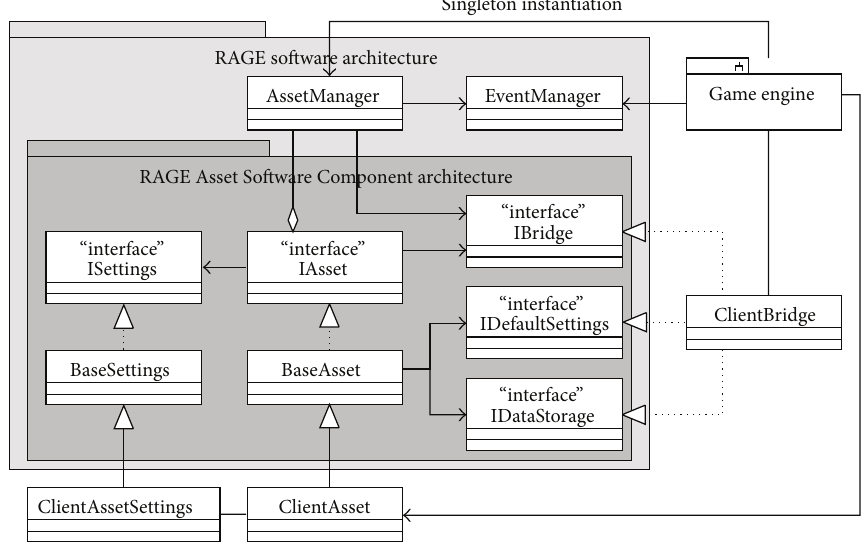
Figure 3: Class diagram reflecting the internal structure of an Asset Software